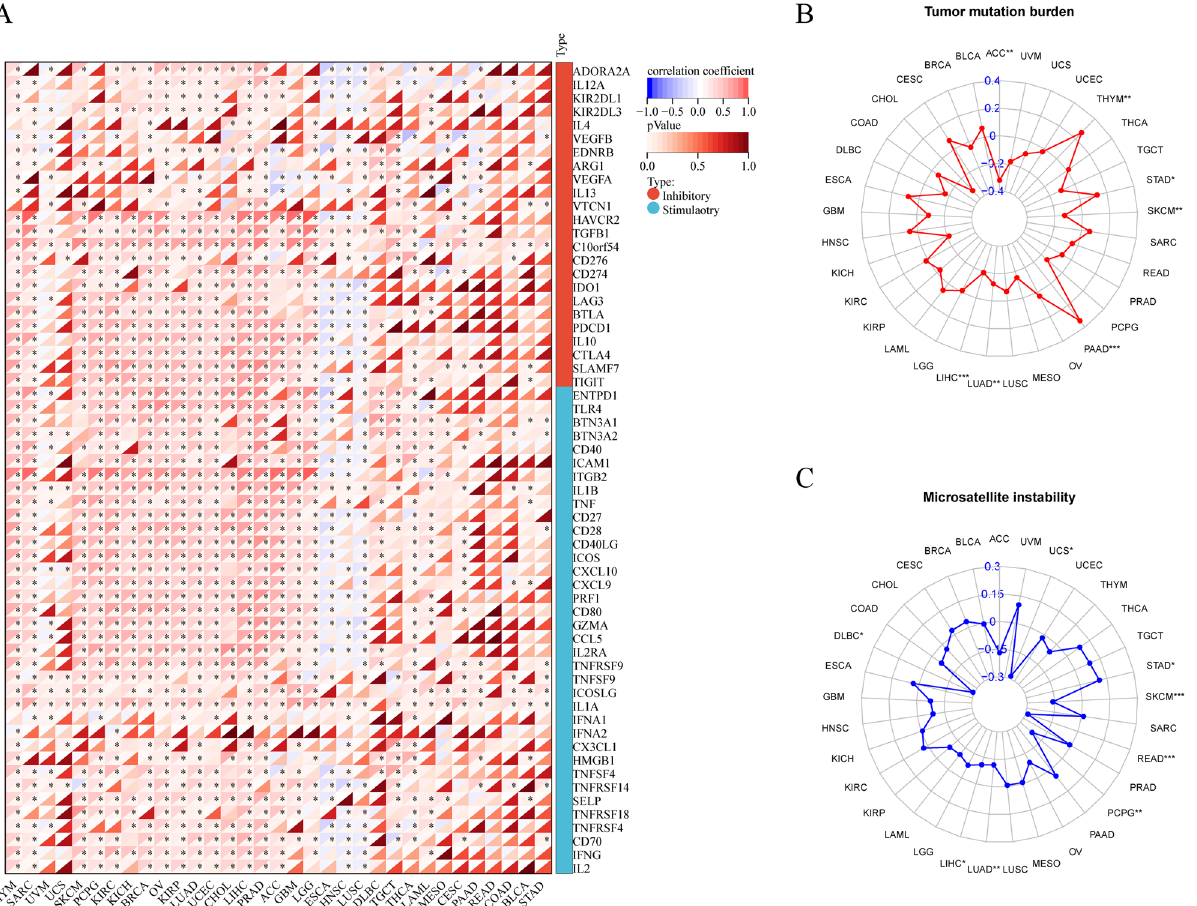
Figure 7. Analysis of immune checkpoint related genes, tumor mutational burden, and microsatellite instability. ( A ) Correlations between 60 ICP-related genes and the expression level of LPAR5 in 33 different types of cancer. ( B ) Association of LPAR5 expression level with tumor mutational burden for 33 different types of cancer. ( C ) Association of LPAR5 expression level with microsatellite instability for 33 different types of cancer. [Figures created by R, version 4.1.3. Sangerbox website (version 3.0; http:// vip. sange rbox. com/ home.